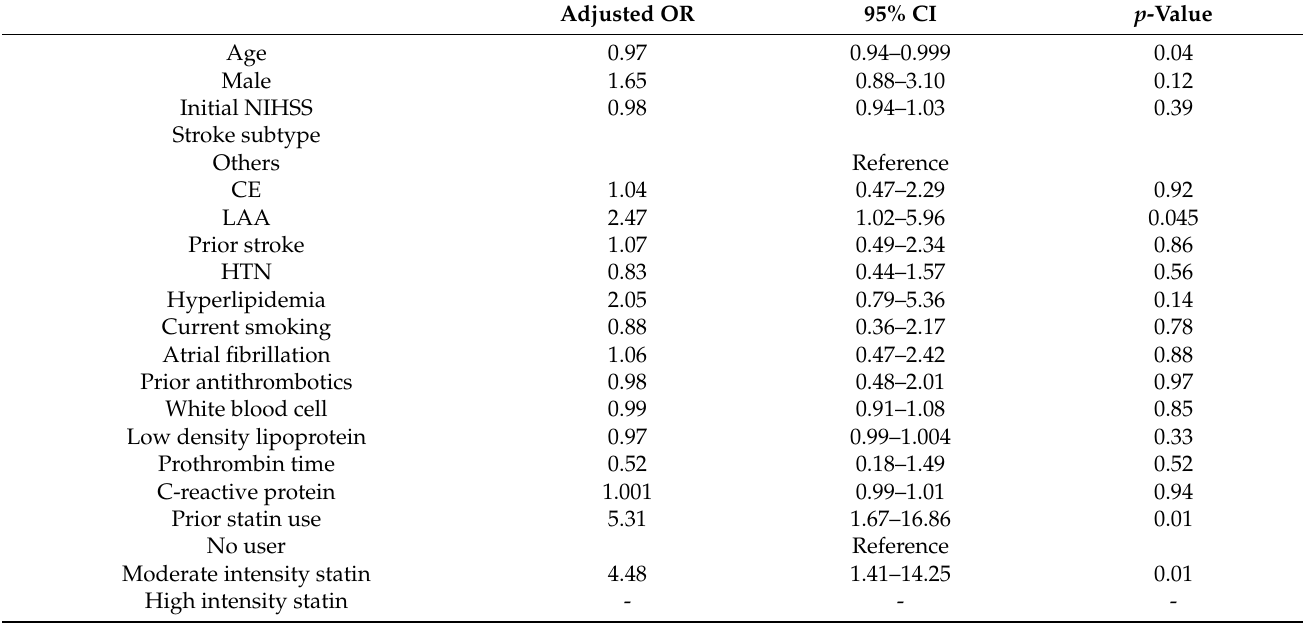
Table 2. Multivariate analysis showing effect of prior statin use on successful reperfusion.